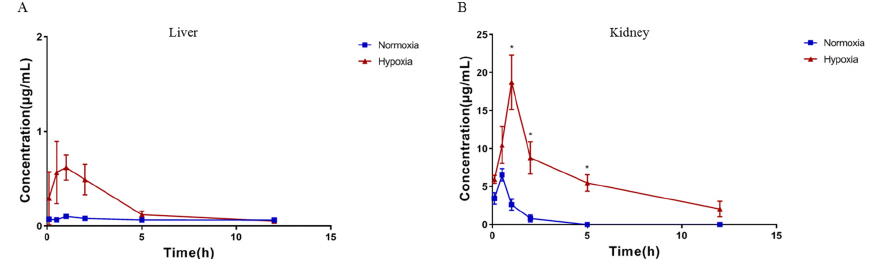
Figure 6. The concentration of acipimox in kidney and liver with and without hypoxia after oral administration to rats ( n = 6 ). ( A ) Mean concentration-time curves of acipimox in liver; ( B ) Mean concentration-time curves of acipimox in kidney. * p < 0.05.